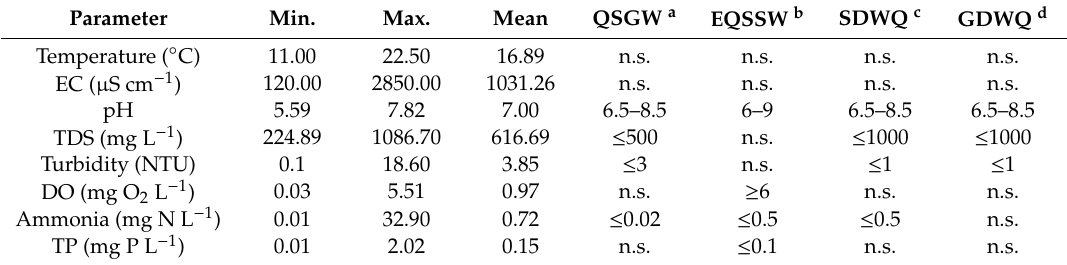
Table 1. Statistical summary of the physicochemical parameters of shallow groundwater in the Su-Xi-Chang region. Parameter Min. Max. Mean QSGW